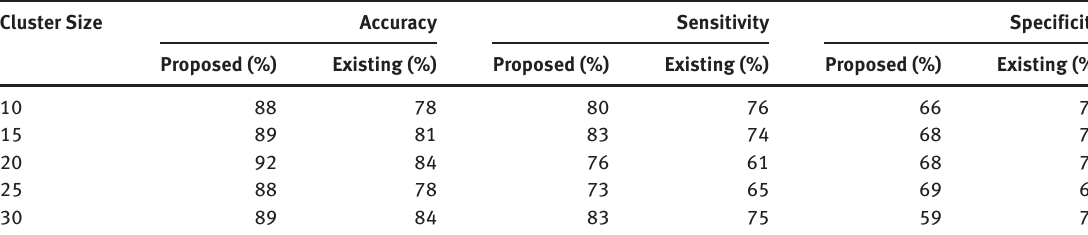
Table 1: Accuracy, Sensitivity, and Specificity Obtained for Cluster Sizes 20, 15, 20, 25, and 30. Cluster